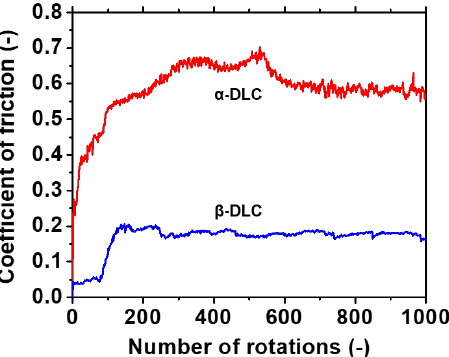
Figure 10. Results of the BoD test for the heat-treated (25 °C, 46% RH) and non-heat-treated (27 °C, 54% RH) samples in group A.